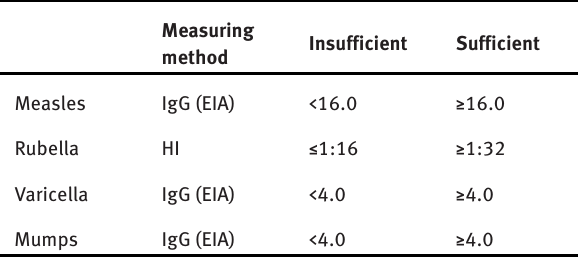
Table 1: Judging criteria of antibody titer against measles, rubella, mumps, and varicella for healthcare workers in our hospital.